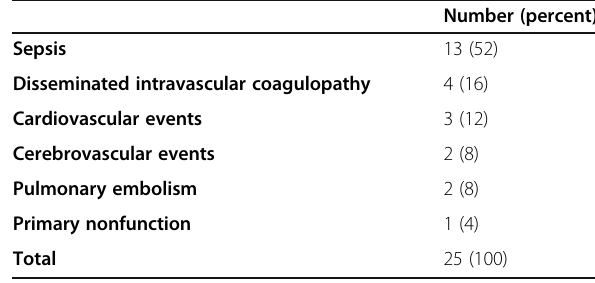
Table 3 The perioperative morbidity data for the study group Table 4 The mortality reasons data for the study